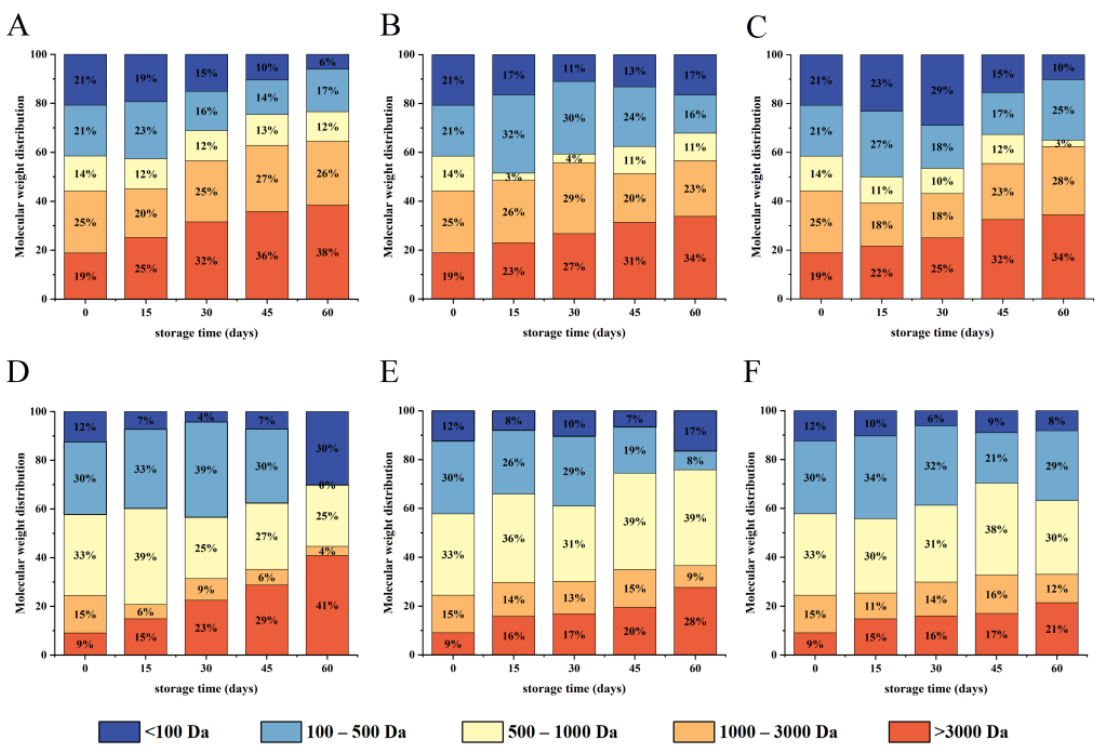
Figure 9. The molecular weight distribution of WPI under different storage conditions (( A , D ) PE; ( B , E ) PA/PE; ( C , F ) PET/AL/PE) after in vitro pepsin digestion ( A – C ) and trypsin digestion ( D – F ).